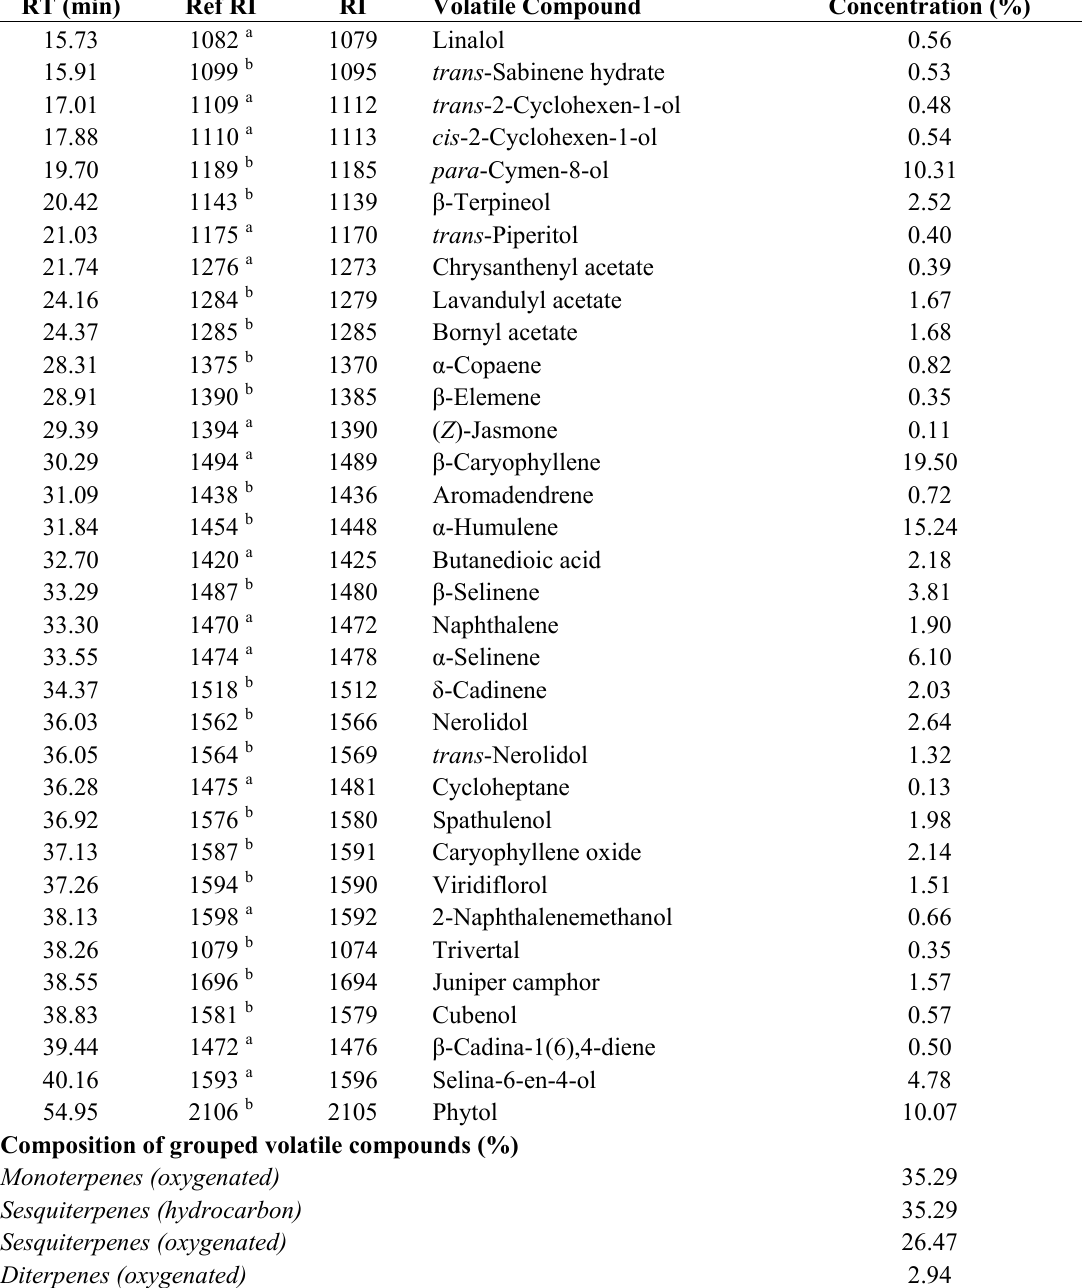
Table 1. Composition (%) of volatile compounds in essential oil of Murraya koenigii from Sabah,